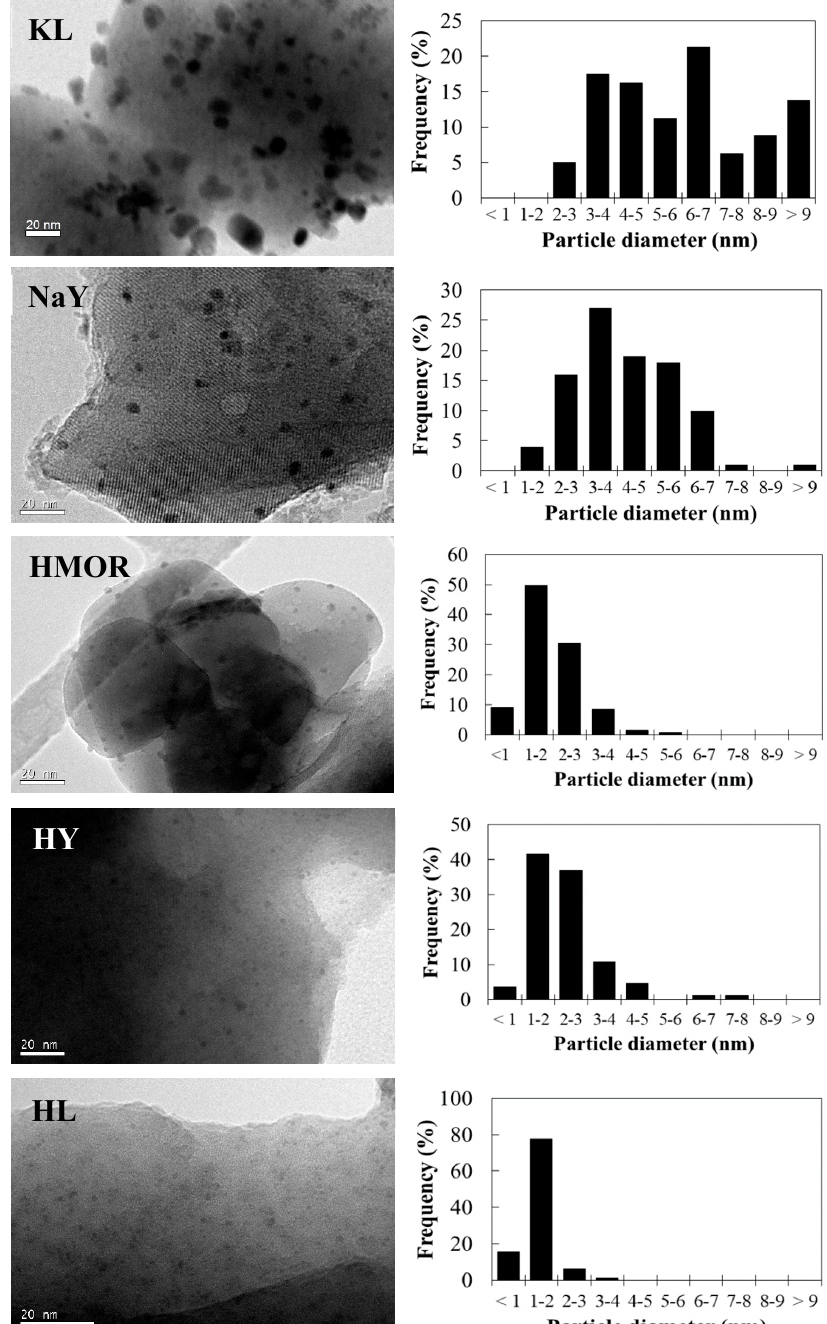
Figure 3. Pd-particle size distribution of the catalysts.